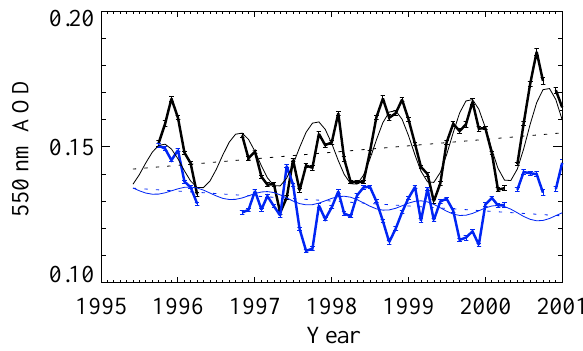
Fig. 7. Global time-series showing the comparison of AVHRR AOD with ATSR-2 AOD between 1995 and 2001. ATSR-2 data are shown in black and AVHRR in blue. The thick lines show the mean value for each month, with error bars indicating the standard error on the mean. Fits to the time-series using Eq. (5) are given by the thin solid lines, and the linear component of these fits are shown by the dotted lines.